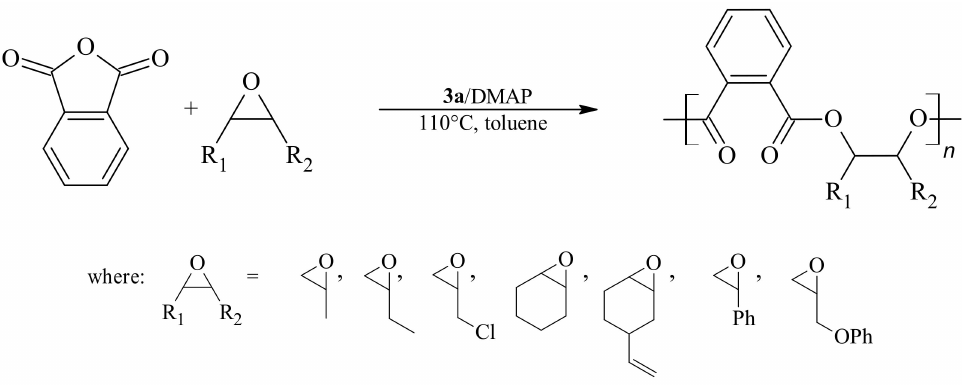
Table 4. Results obtained for the ROCOP reactions of PA with various epoxides in the presence of 3a /DMAP. Run